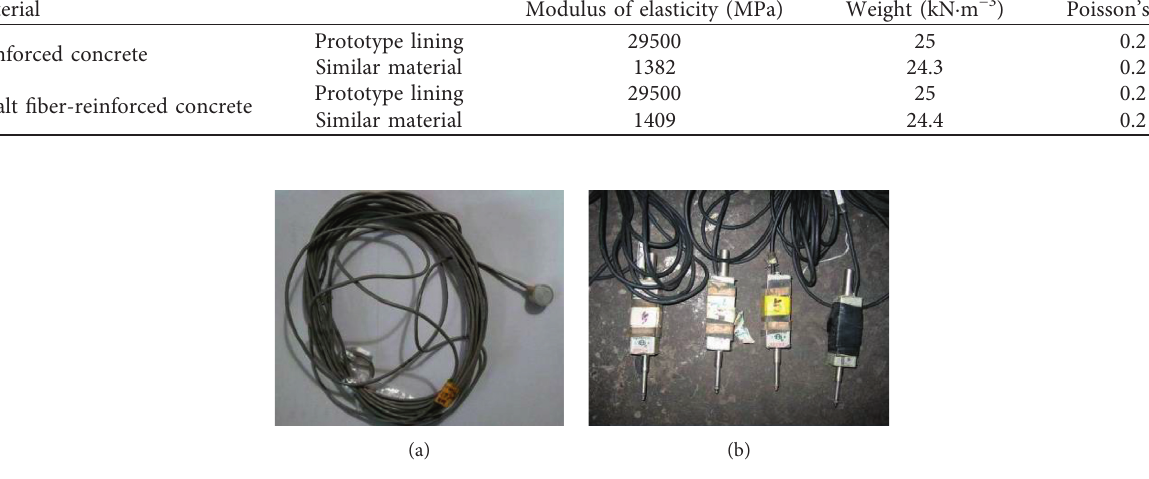
Figure 5: Test sensor. (a) Miniature pressure box; (b) displacement sensor.